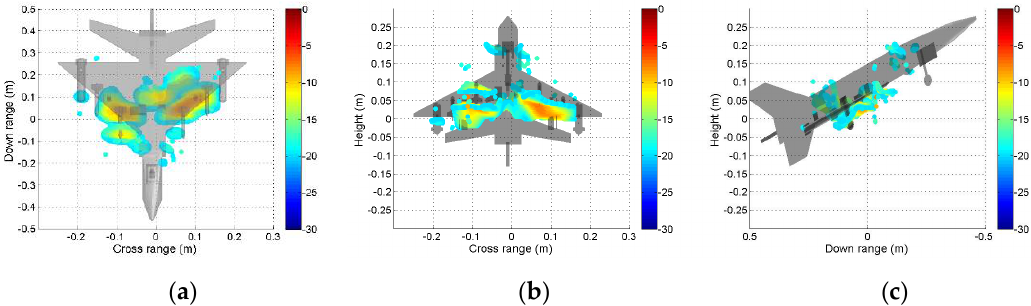
Figure 11. Tomography result in HV polarization. Three views of the airplane model are shown: ( a ) top view; ( b ) bottom view; ( c ) side view.